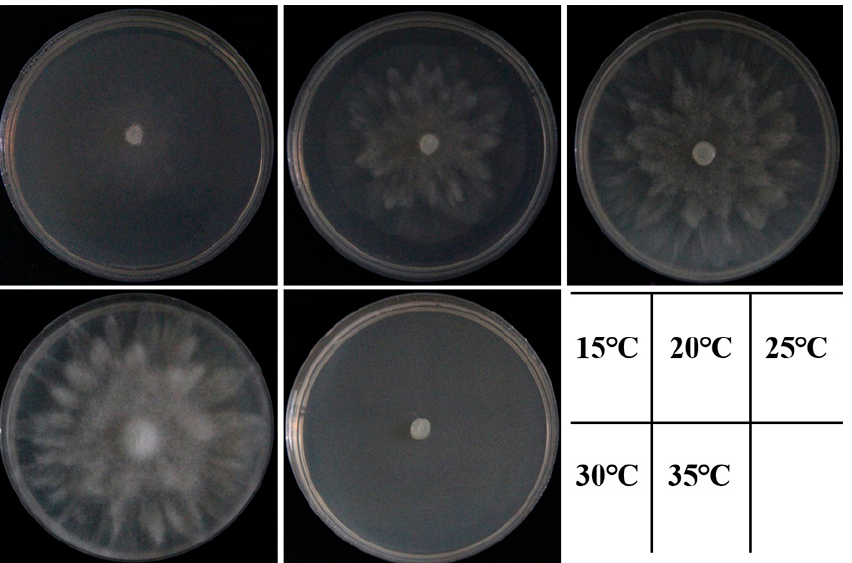
Figure 6. Colony morphology of the isolate ZS01 after 3 days of culture on V8-agar medium at 15, 20, 25, 30 and 35 °C.